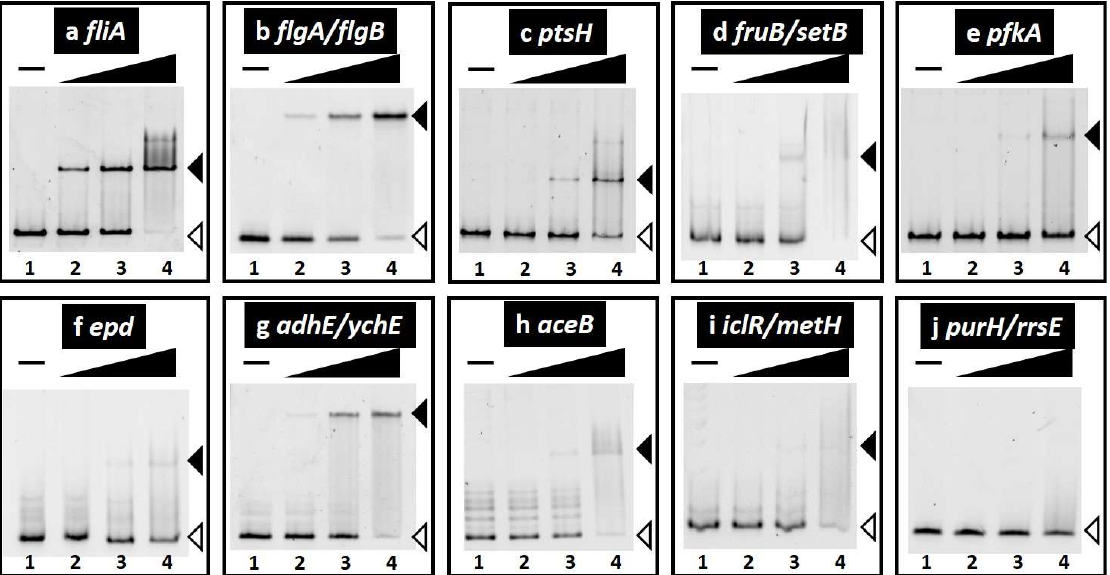
Figure 3. Gel shift assay of FlhDC–DNA complex formation. ( a – j ) Purified FlhDC was mixed with 0.1 pmol of each target DNA probe of the FlhDC-binding regions shown in Table 1 (also see Figure S2). FlhDC added: lane 1, 0 nM; lane 2, 10 nM; lane 3, 30 nM; lane 4, 100 nM. The filled triangles indicate the FlhDC–DNA probe complex, whereas open triangles indicate free probes.